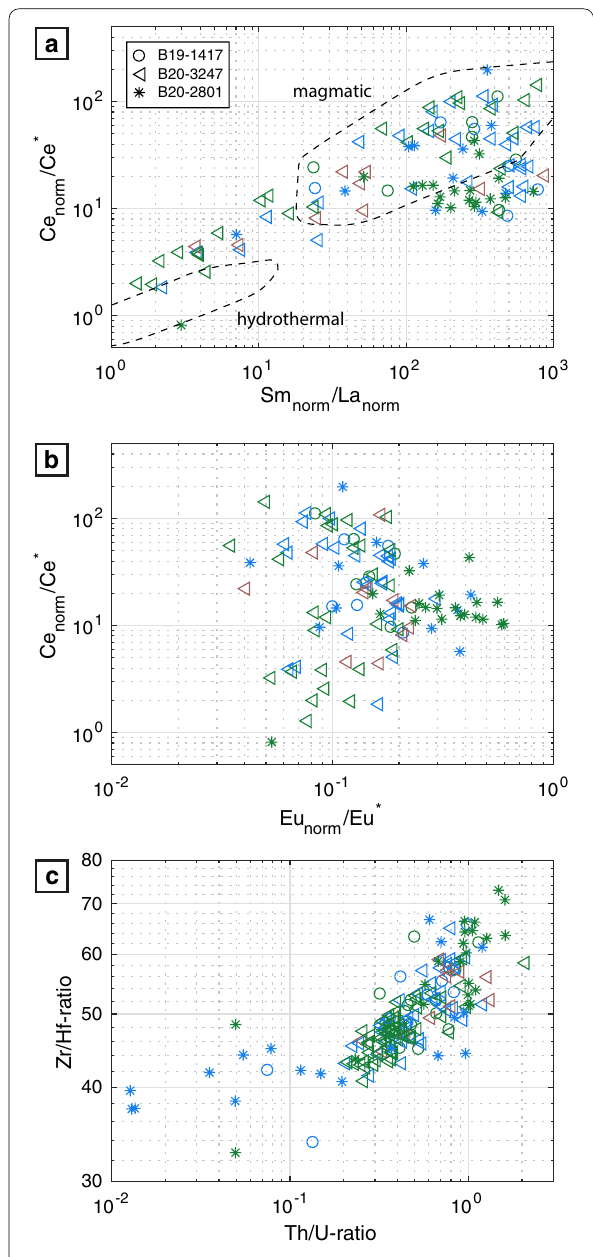
Fig. 14 Trace element ratios of zircons from samples B19-1417 (RG1), B20-3247 (RG2), and B20-2801 (QB-SZ). The subscript ‘norm’ indicates normalized values (chondrite-noramlized after Sun and McDonough, 1989). Colors indicate different textures of the zircons and correspond to the legends in Figs. 13a–c. a Sm–La-ratio (chondrite-normalized) versus Ce anomaly, where Ce ∗ is defined by ( La norm + Pr norm )/ 2 . Magmatic and hydrothermal domains after Hoskin (2005). b Eu anomaly versus Ce anomaly, where Eu ∗ is defined by ( Sm norm + Gd norm )/ 2 . c Th–U-ratio versus